Question: Give a one-sentence summary of this figure.
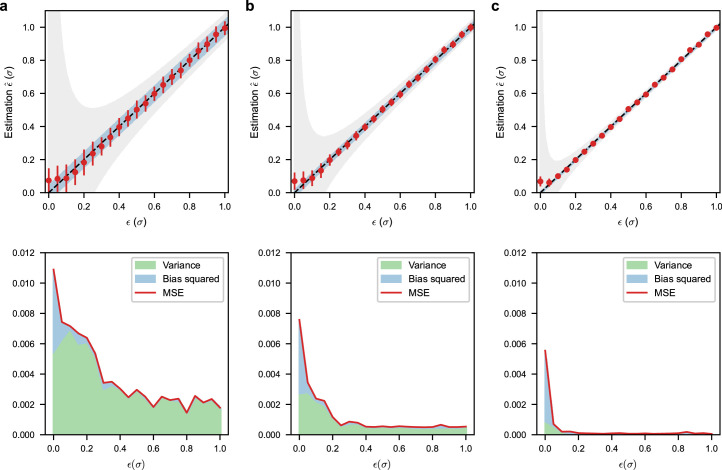
Answer: Experimental estimation results. MLEs (red) with raw estimators (yellow), both derived from 10 4 total detected photons. The markers and error bars denote the means and standard deviations derived from 50 bootstrap resamples. The dashed black line indicates the ground truth separation. The shaded regions illustrate the theoretically predicted standard deviations from the quantum CRLB (blue) and the DI measurement CRLB (grey).